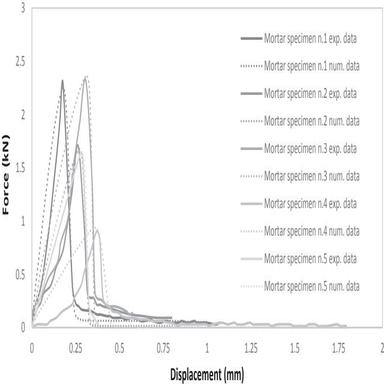
Comparison between the experimental and numerical results from the optimization process with the Levenberg-Marquardt algorithm for the 3-point bending test on mortar.